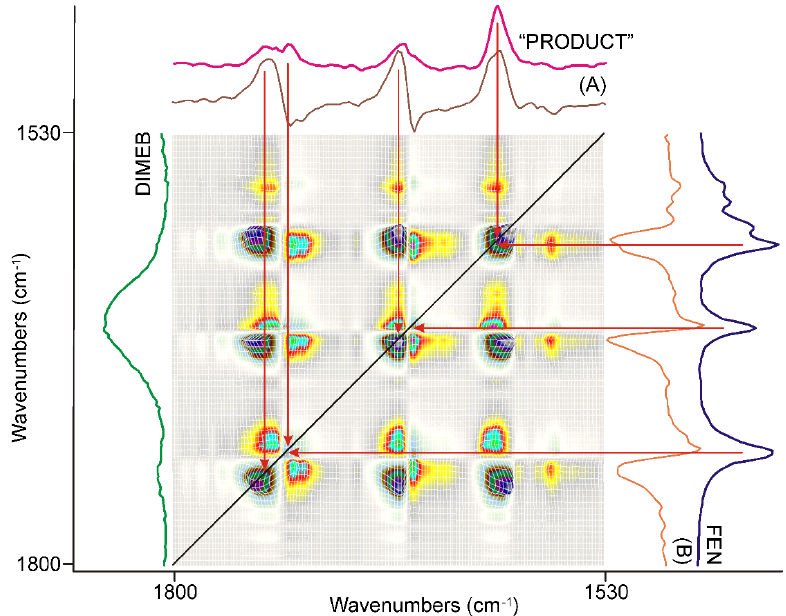
Figure 7. The synchronous correlation surface calculated from the spectra recorded during the second 20 min long period of time, between 1800 and 1530 cm − 1 , showed a much more complex picture than that of the previous 20 min. The axial sections were taken at 1740 cm − 1 (A) and 1726 cm − 1 (B), confirming that the formation of a kind of product was the dominating process, while the consumption of FEN had a lesser contribution. The spectrum of “PRODUCT” was calculated from the average of all spectra recorded during the full grinding process by consecutive subtraction of the spectra of the starting materials, FEN and